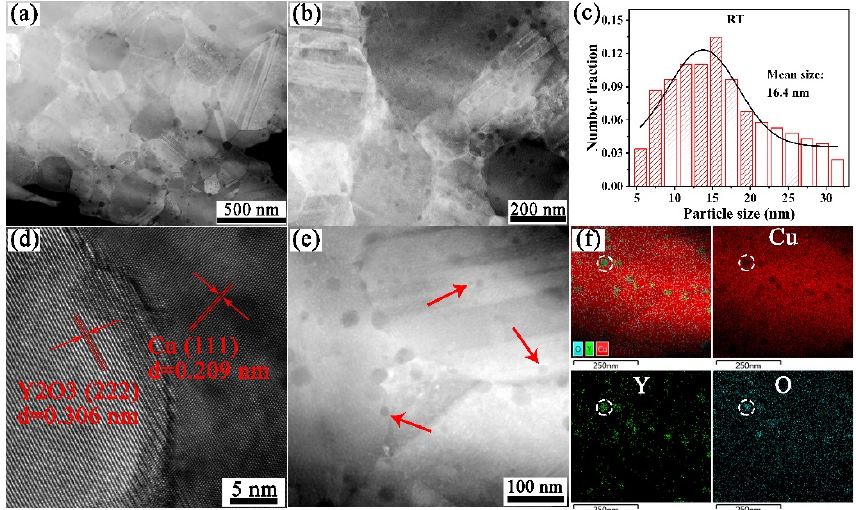
Figure 5. DF-STEM images ( a , b ), Y 2 O 3 particles size distribution ( c ), HRTEM images of Cu and Y 2 O 3 phase interface ( d ), and elemental distribution mapping ( e , f ) of Cu-1wt.%Y 2 O 3 alloy.